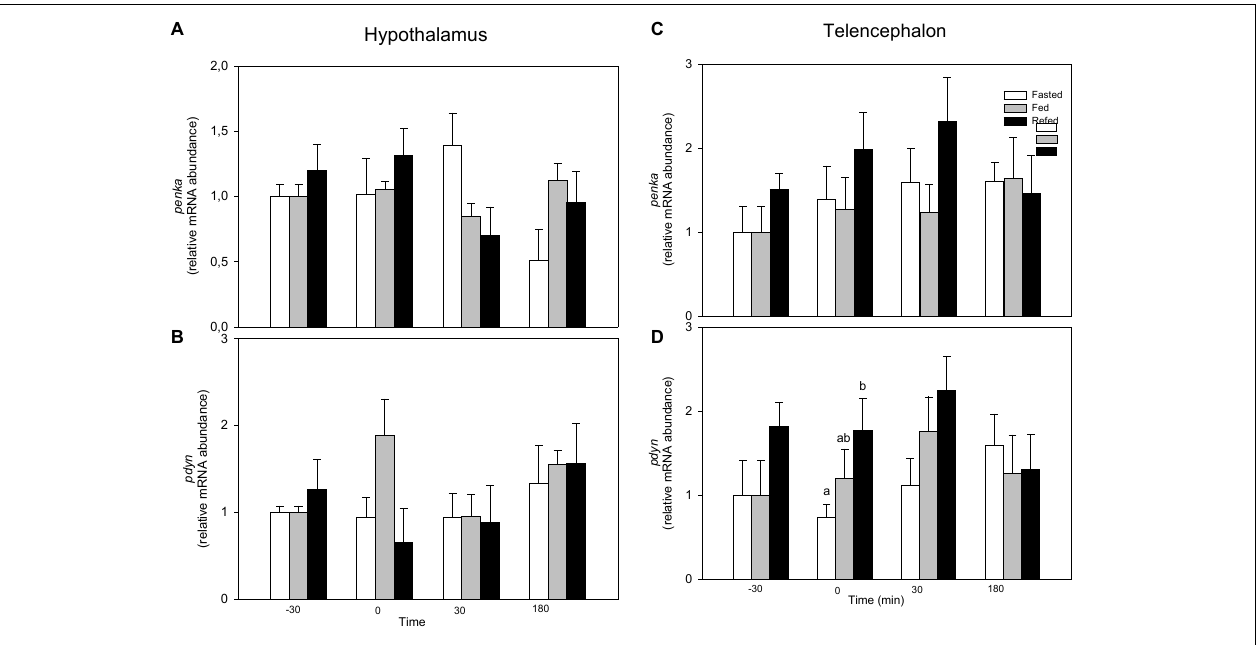
FIGURE 2 | mRNA abundance of penka (A,C) and pdyn (B,D) in hypothalamus (A,B) and telencephalon (C,D) of fasted, fed an refed rainbow trout sampled at different periprandial times ( − 30, 0, 30, 180 min). Each value is the mean + S.E.M. of 6 fish. Different letters indicate significant differences ( P < 0.05) among feeding condition within each sampling